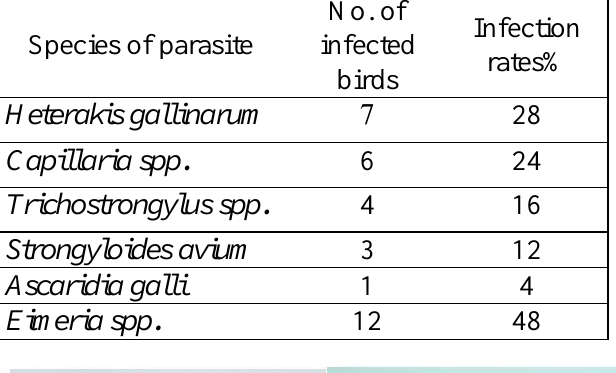
No. of Infection infected rates% birds